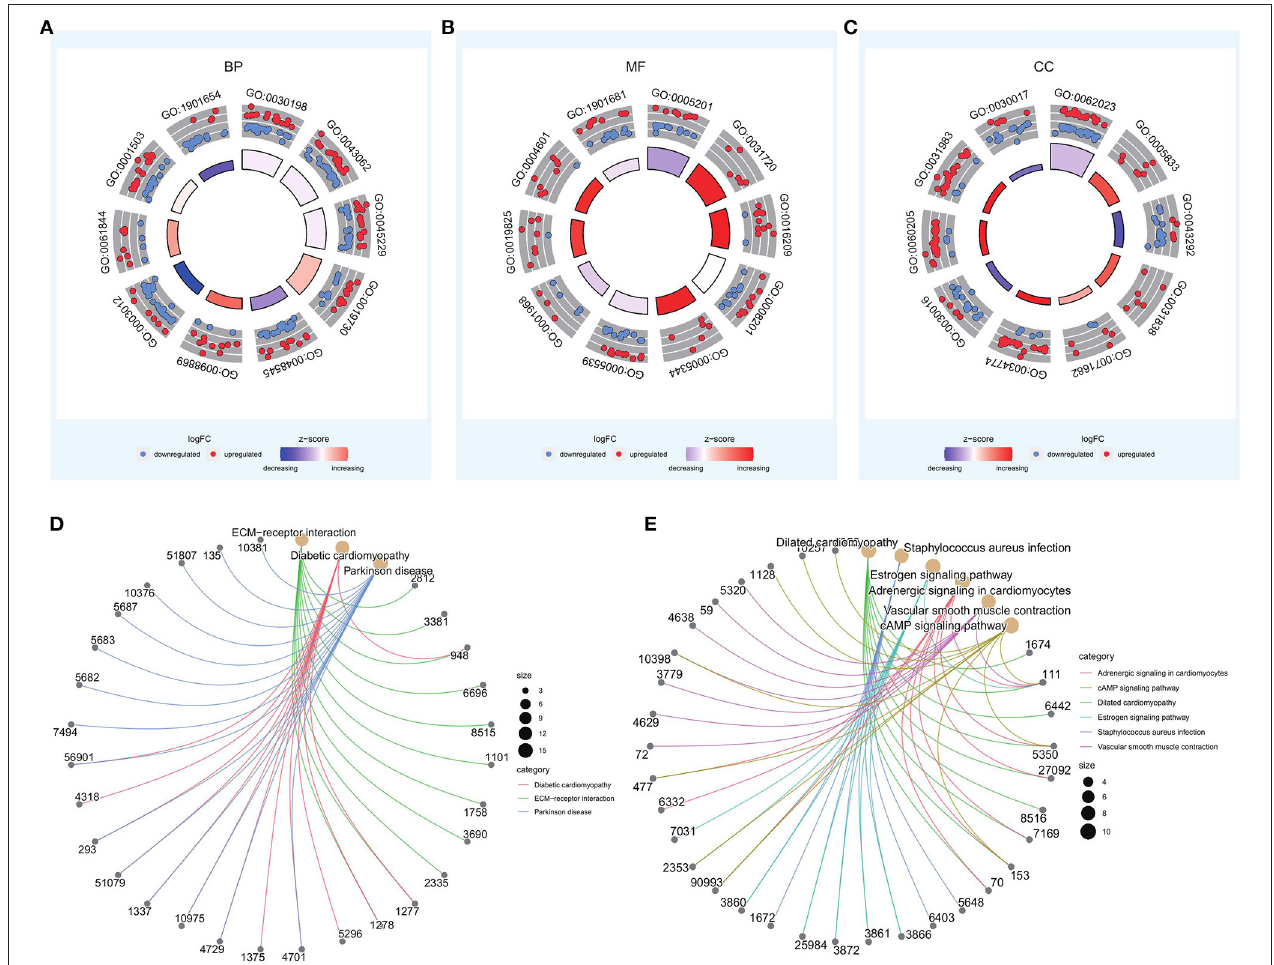
FIGURE 5 | GO and KEGG enrichment analyses of differentially expressed genes in high- and low-risk groups. (A–C) Top 10 entries of biological process (BP), molecular function (MF), and cellular component (CC) in GO enrichment results. (D,E) Results of KEGG enrichment for upregulated and downregulated genes.